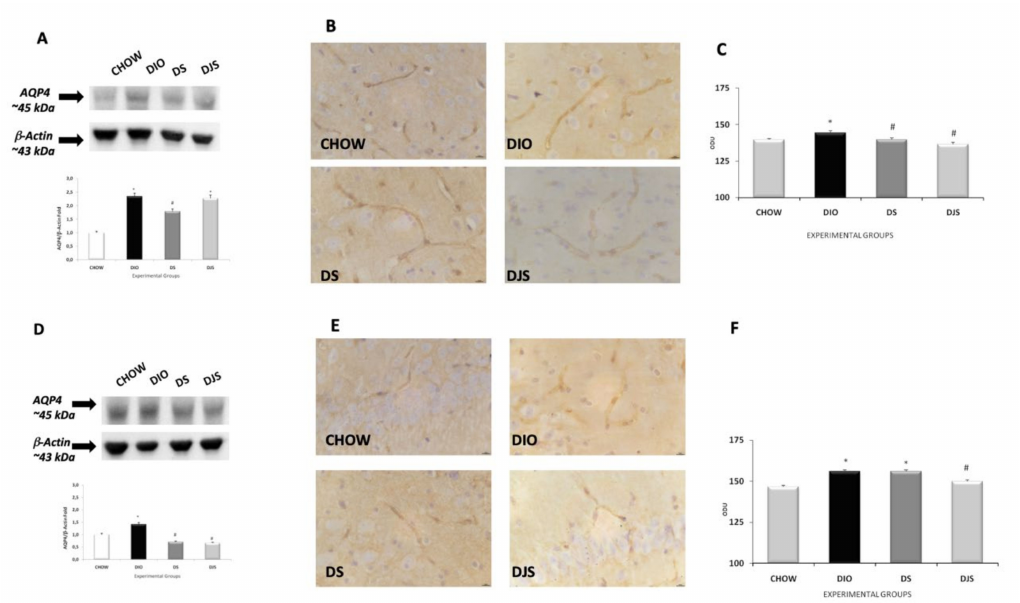
Figure 6. Expression of aquaporin 4 (AQP4) as a blood–brain barrier marker. Western blot analysis (representative of three di ff erent experimental sessions) for samples of the frontal cortex ( A ) and hippocampus ( D ) probed for AQP4 and β -Actin, with the corresponding densitometric analysis of the bands. Sections of the frontal cortex ( B ) and CA1 subfield of the hippocampus ( E ) processed for AQP4 immunohistochemistry and the corresponding morphological analysis of the mean area of immunoreaction for the frontal cortex ( C ) and hippocampus ( F ). The values are the mean ± S.E.M.; ∗ p < 0.05 vs. CHOW rats; # p < 0.05 vs. DIO rats. Calibration bar: 25 µ